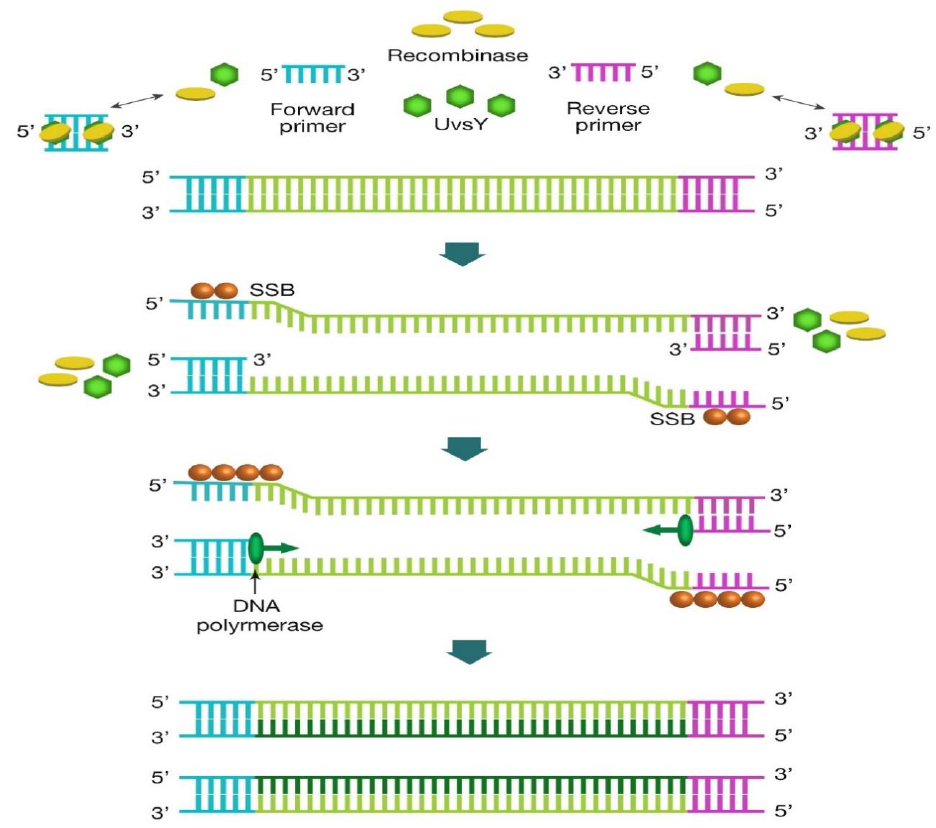
Figure 4. Recombinase polymerase amplification schematic representation. It begins with the binding of recombinase (T4 uvsY and uvsX; green diamonds and orange circles, respectively) to forward and reverse primers, which forms a complex that search for homologous sequences in double stranded DNA. Strand exchange reaction occurs once the homology is found. The single strand binding proteins (SSB, T4 gp32 protein; brown circles) aligns to unwound DNA strand, allowing DNA polymerase ( Bacillus subtilis Pol I, Bsu; green circles) to initiate template amplification using the two primers, forming two double stranded DNA. The repetition of the cycle leads to exponential amplification.